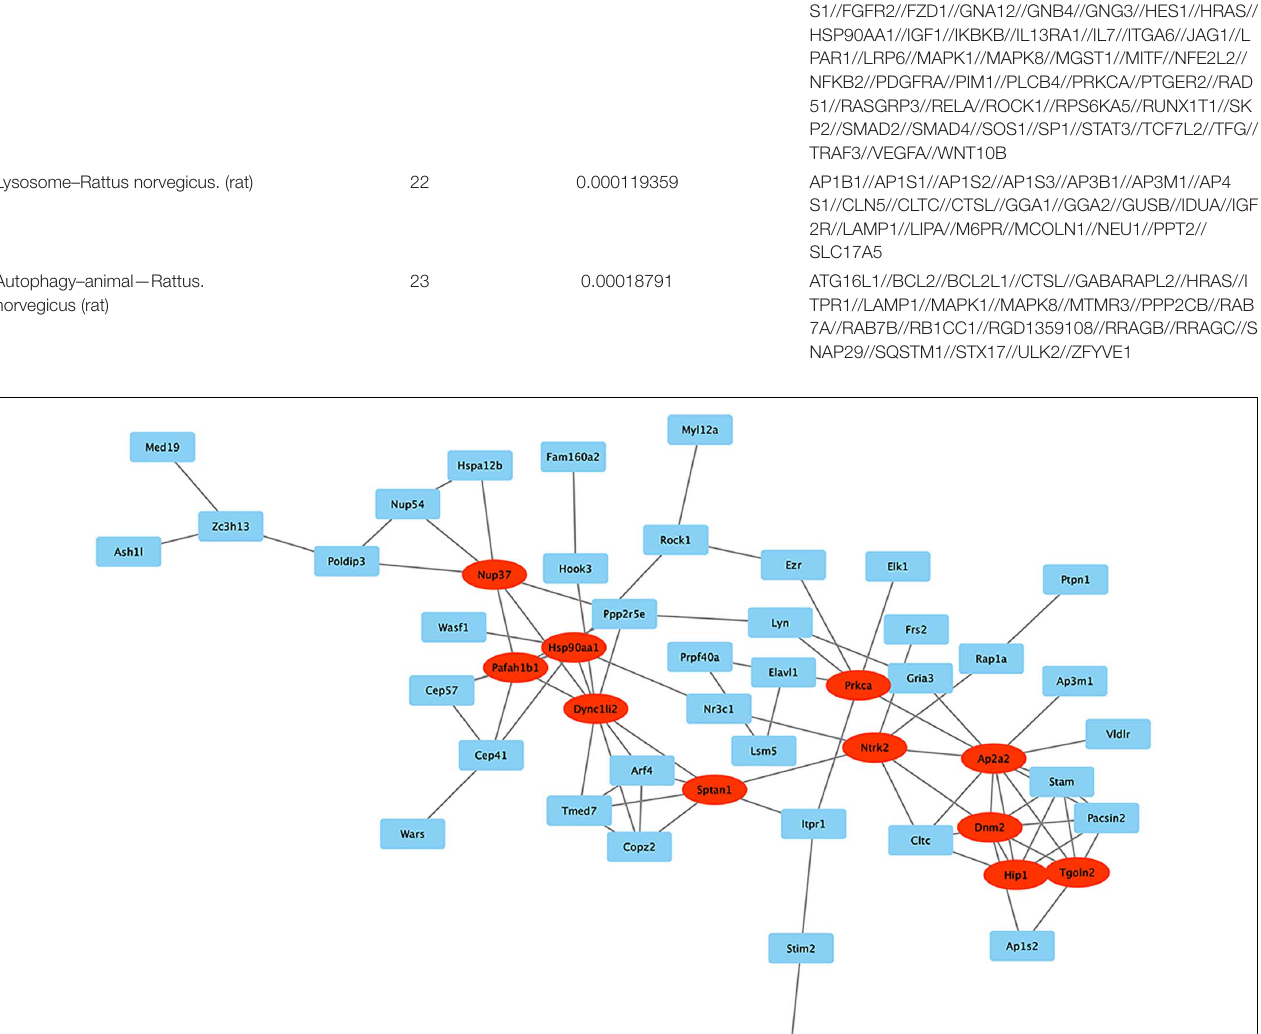
perturbed energy homeostasis, DNA damage, and accumulation of misfolded/aggregated proteins (Beane et al., 2014). KEGG and GO analyses were performed to determine the differentially expressed mRNAs in the two groups of